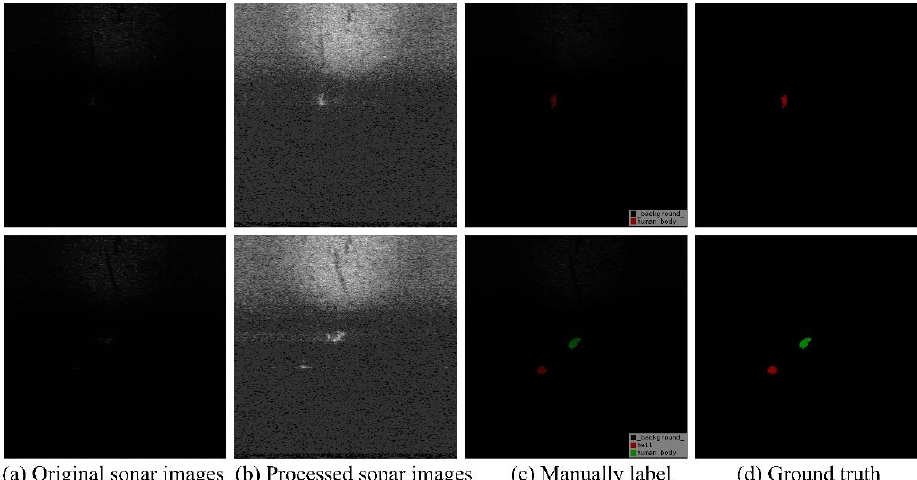
Figure 5. Several images in STSD, where ( a ) represents the original sonar images, which are dis- played as nearly black images, ( b ) represents the log-transformed sonar images, ( c ) is the manually label annotated by using LabelMe software and ( d ) is ground